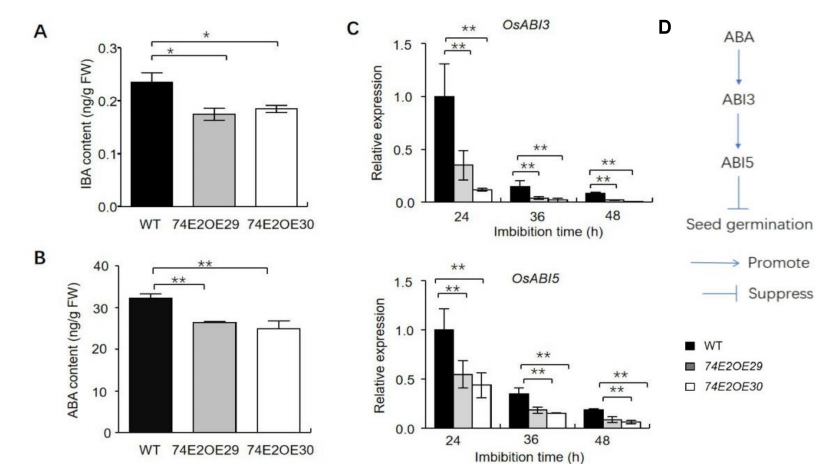
Figure 4. UGT74E2 altered IBA and ABA contents in germinating rice seeds. ( A ) The contents of IBA in germinating WT and UGT74E2 transgenic rice seeds after being imbibed for 24 h. ( B ) The contents of ABA in germinating WT and UGT74E2 transgenic rice seeds after being imbibed for 24 h. ( C ) Expression of OsABI3 and OsABI5 in germinating seeds in WT and UGT74E2 transgenic rice. Gene expression was normalized to the reference gene OsActin . For each experiment, three replicates were done; data are presented as means ± SD. Student’s t -test for each genotype was performed (* p < 0.05, ** p < 0.01). ( D ) Role of ABI3 and ABI5 genes in the ABA signaling pathway during seed